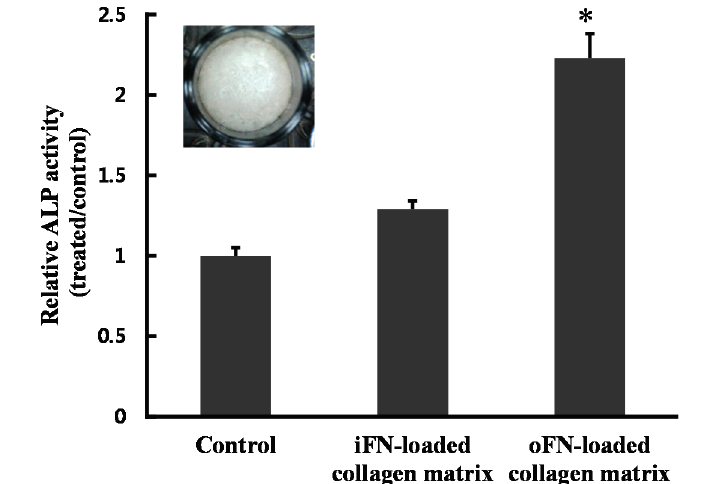
Figure 4. Alkaline phosphatase (ALP) activity in MC3T3-E1 cells seeded on fibronectin-loaded collagen matrix, at 10 days. Collagen matrices were placed in 24-well plates, and MC3T3-E1 cells were cultured on collagen matrices loaded with integrin-binding fibronectin (iFN) or osteoinductive fibronectin (oFN, 5 μ g·mL − 1 ). Inset: image of a collagen matrix. The results are reported as mean ± standard deviation ( n = 3). * p < 0.05 compared with iFN-loaded groups or